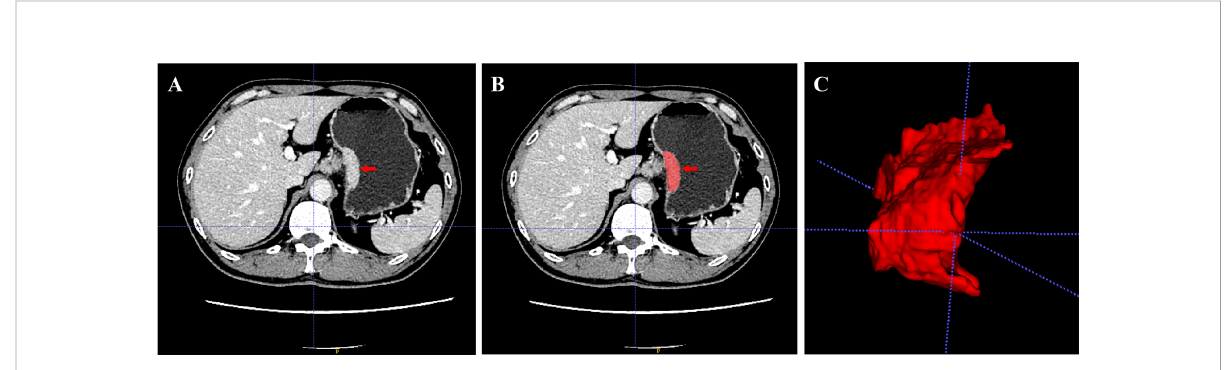
FIGURE 2 Manual segmentation of tumor with a GC patient. (A) A slice portal venous phase of contrast-enhanced CT images of the tumor. (B) the red label masks a slice CT image of the tumor with manual segmentation. (C) Three-dimensional (3D) image of the tumor with manual